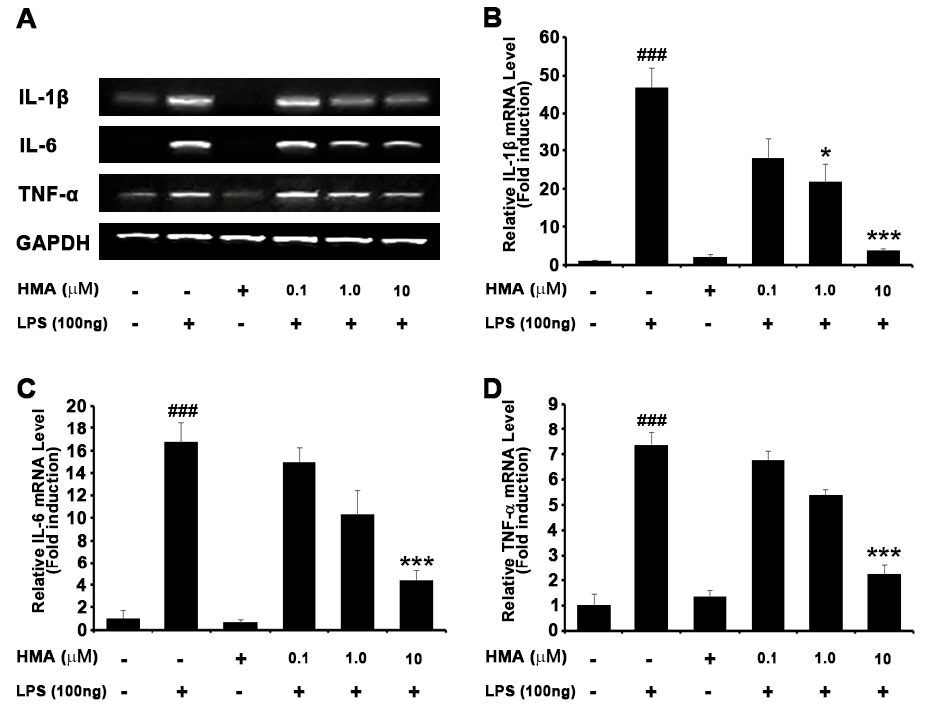
Figure 3. Effect of HMA on proinflammatory cytokines expression in LPS-stimulated BV-2 microglia cells. BV-2 cells were seeded overnight in 6-well plates, and incubated with LPS (100 ng / mL) for 6 h and pretreated with HMA (0.1, 1, and 10 µ M) for 1 h. Measurement of the expression level of proinflammatory cytokines (interleukin (IL)-1 β , nuclear factor kappa beta (TNF- α ), and IL-6) on mRNA level used RT-PCR ( A ) and the corresponding quantification data are shown ( B – D ). GAPDH was used as an internal control. Data are presented as the mean ± SEM ( n = 3) performed in three independent experiments. ### p < 0.001 as compared with the control group; * p < 0.05 and *** p < 0.001 as